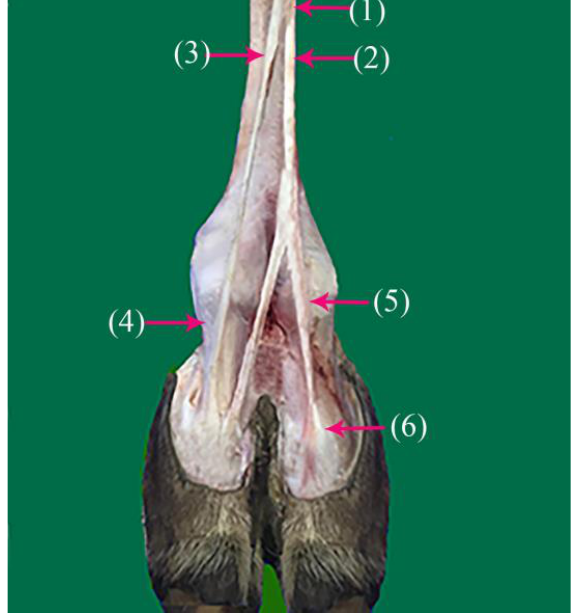
Figure 2. Nerve supply of the dorsal surface of the phalanx of the hindlimb in camels: (1) superficial fibular nerve; (2) common dorsal digital nerve of the third digit; (3) common dorsal digital nerve of the fourth digit; (4) abaxial dorsal proper digital IV nerve; (5) axial dorsal proper digital IV nerve; (6) abaxial dorsal proper digital III nerve.